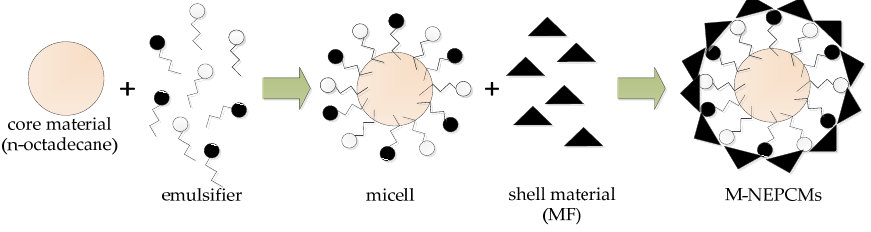
Figure 1. The principle of in ‐ situ polymerization method.